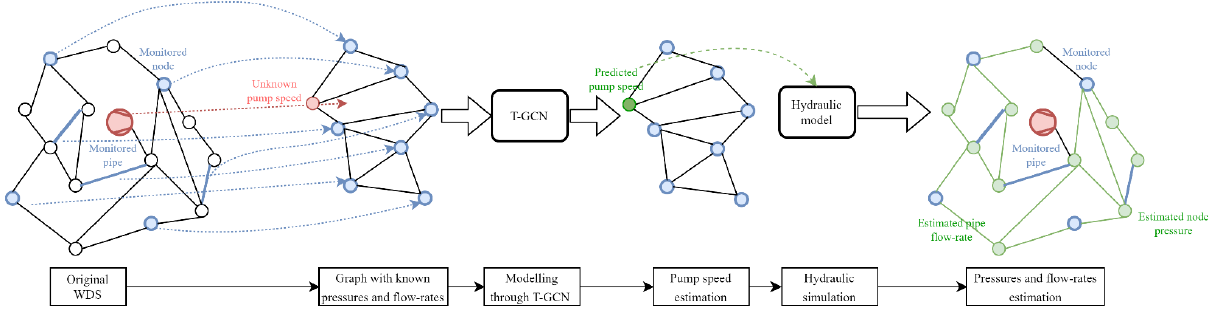
Figure 2. Methodology for pressure and flow rate estimation based on estimated relative pump speeds.